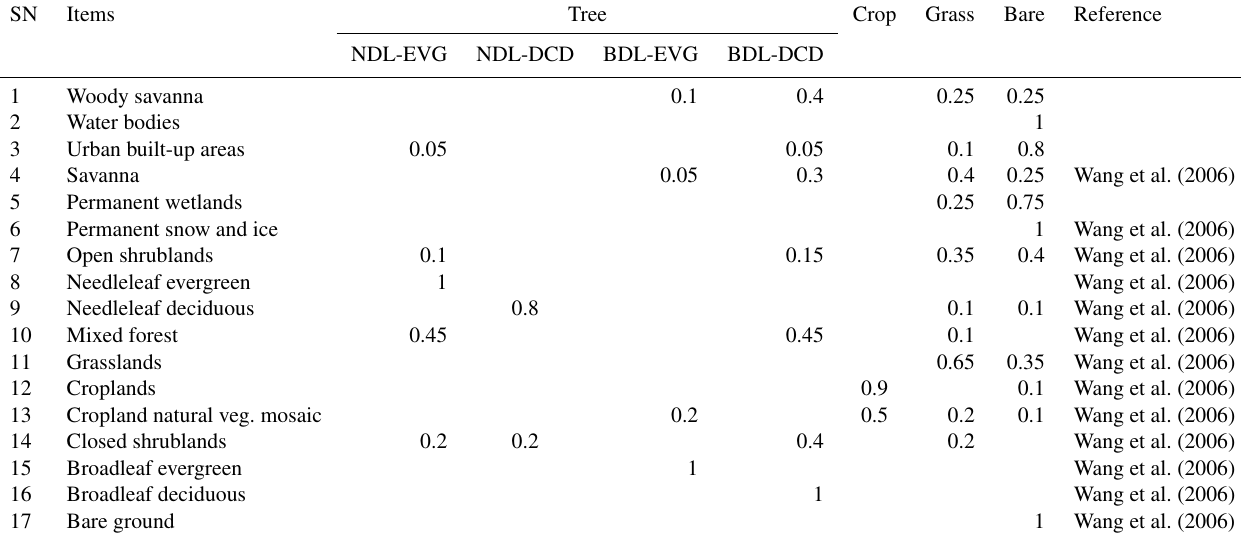
Table 2. Reclassification of the 17 MODIS land cover classes into the nine CTEM PFTs.